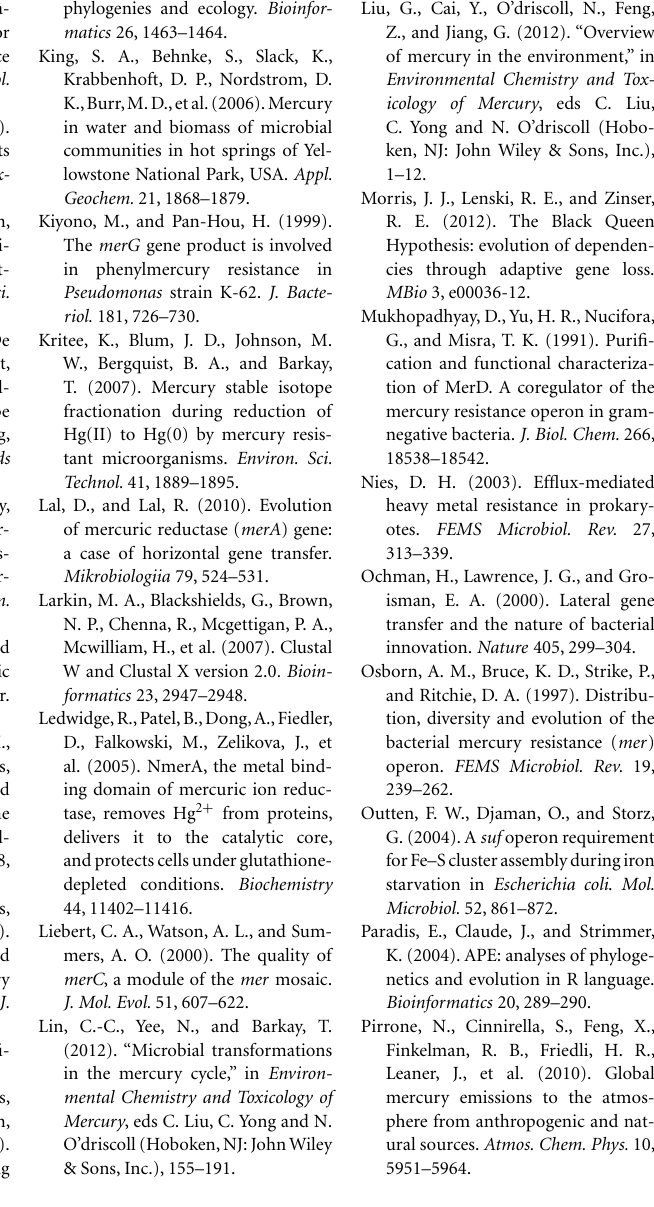
Figure S13 |The taxonomic distribution of theTRASH metal binding domain protein mapped on the MerA phylogenetic tree, as indicated by blue crosses to the right of the sequence terminal. Phylum level taxonomic rankings are overlaid by color on each lineage. Figure S14 | Phylogenetic reconstruction of MerP, as determined using the Neighbor-Joining method. The tree is rooted with a paralogous pair of proteins that are putatively involved in heavy metal transport/detoxification. Figure S15 | Phylogenetic reconstruction of MerT, as determined using the Neighbor-Joining method. The tree is rooted with a paralogous pair of proteins that are involved in binding